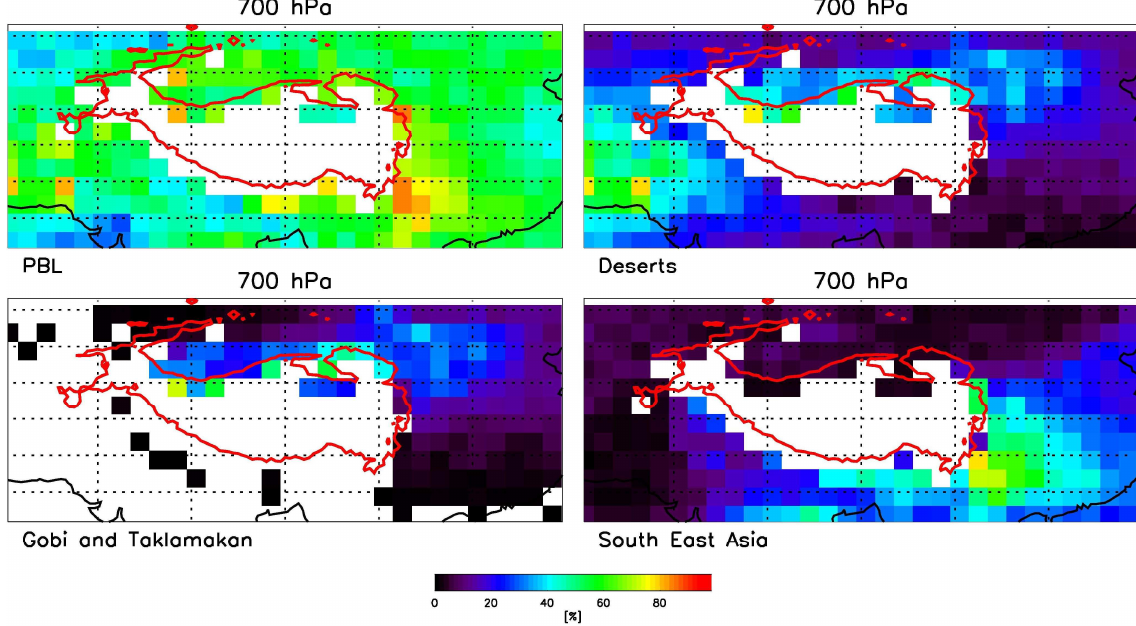
Fig. 8. Frequency of occurrence of air masses at 750hPa coming from different PBL sources (top left panel: whole PBL, as defined in the text; top right: PBL above deserts; bottom left: PBL above deserts north of the plateau; bottom right: PBL above carbon aerosol emissive regions). Color scale is the same as Figs. 1–4.